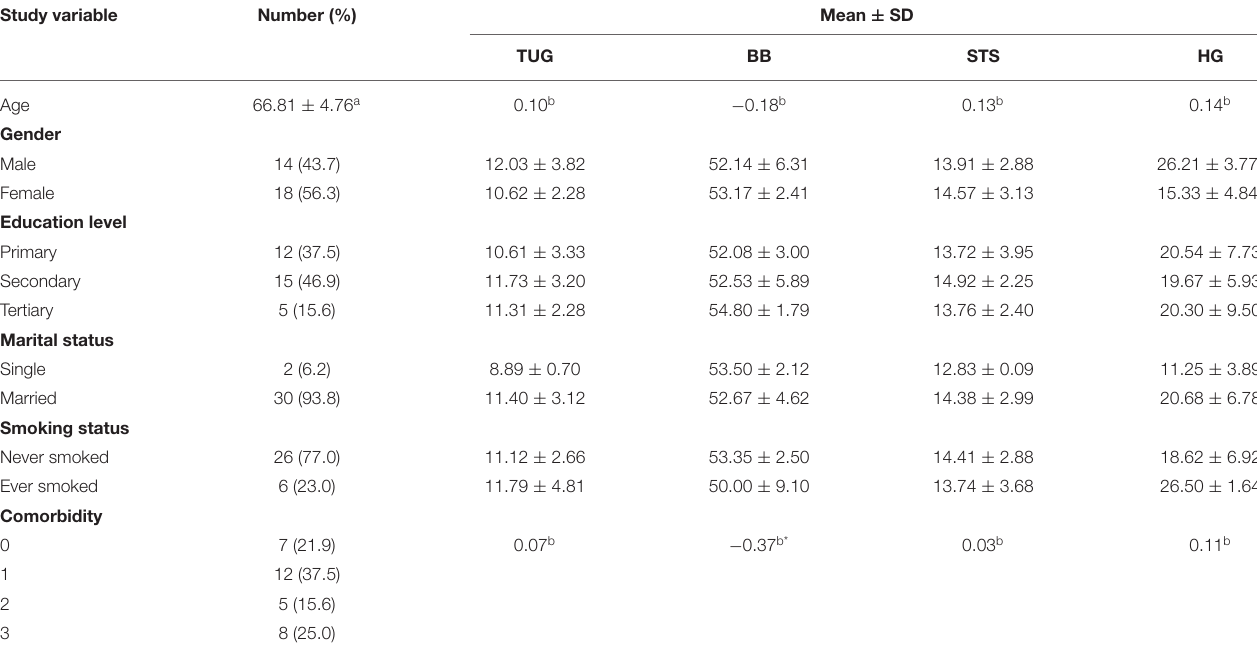
TABLE 2 | Characteristics of subjects and baseline comparison for timed up and go, Berg balance, sit-to-stand, and hand grip strength measurement. Study variable